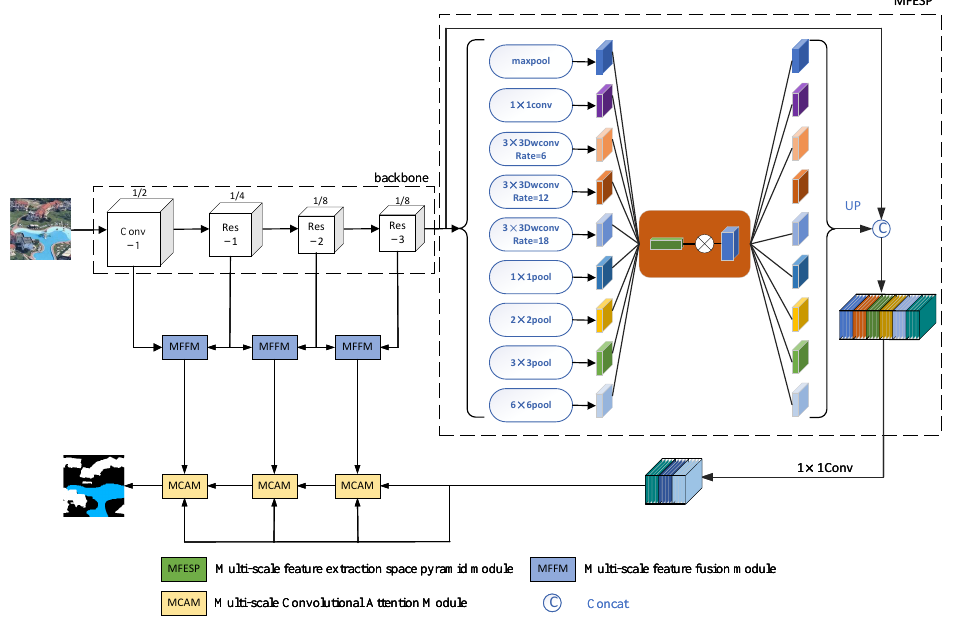
Figure 1. Multi-Scale Feature Aggregation Network framework